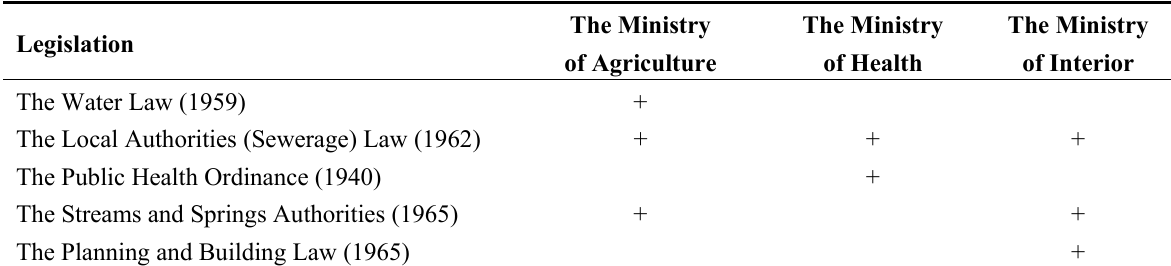
Table 1. Relevant legislation for water pollution control and the actors entrusted with the ministerial responsibilities over them, 1948–1989.